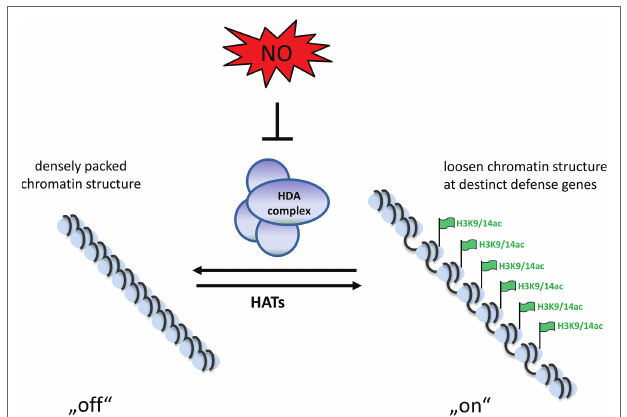
FIGURE 1 | Schematic model of NO-induced chromatin modulation. Due to the activity of HDAs the chromatin is densely packed and genes are not transcribed. Upon formation of NO, the HDA-complexes become inhibited by S-nitrosation, leading to acetylation of the chromatin. This loosen chromatin structure allows transcription in tight interplay with activating transcription